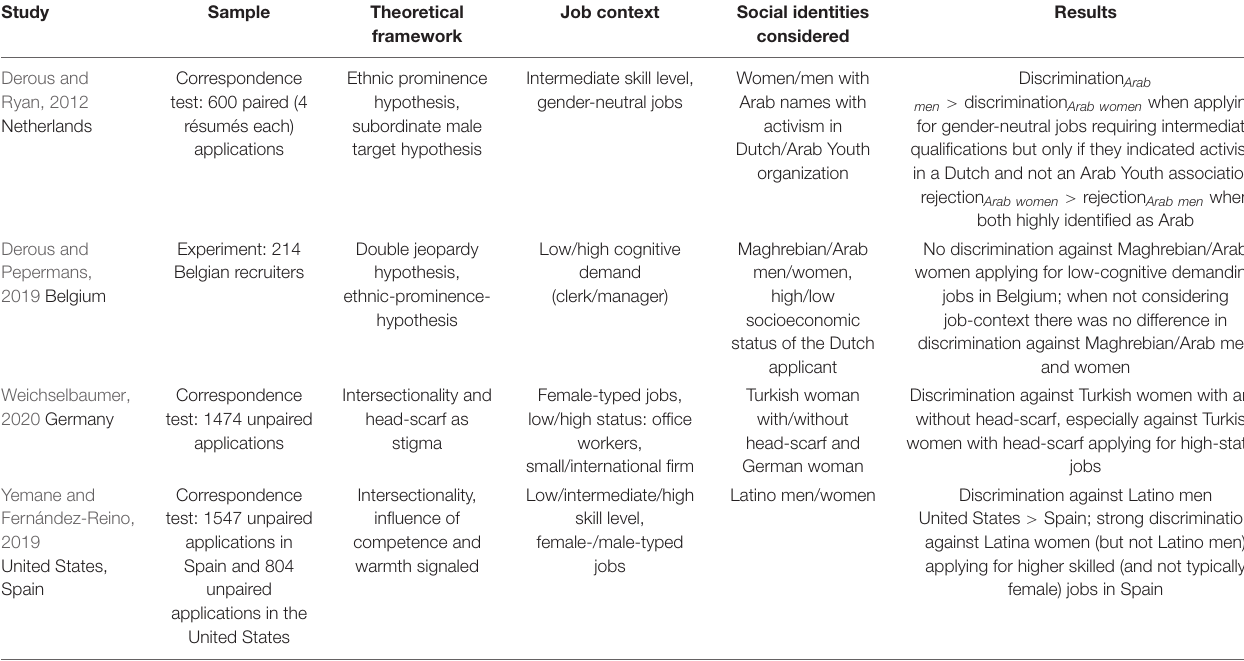
TABLE 5 | Overview of European social psychological studies on labor market discrimination based on the double jeopardy